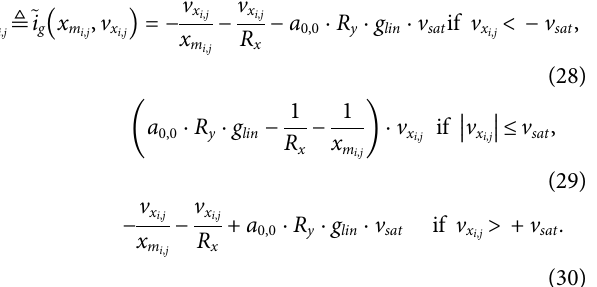
FIGURE 9 | (A) Course of κ ( v m evolution function Eq. 23 , and preventing